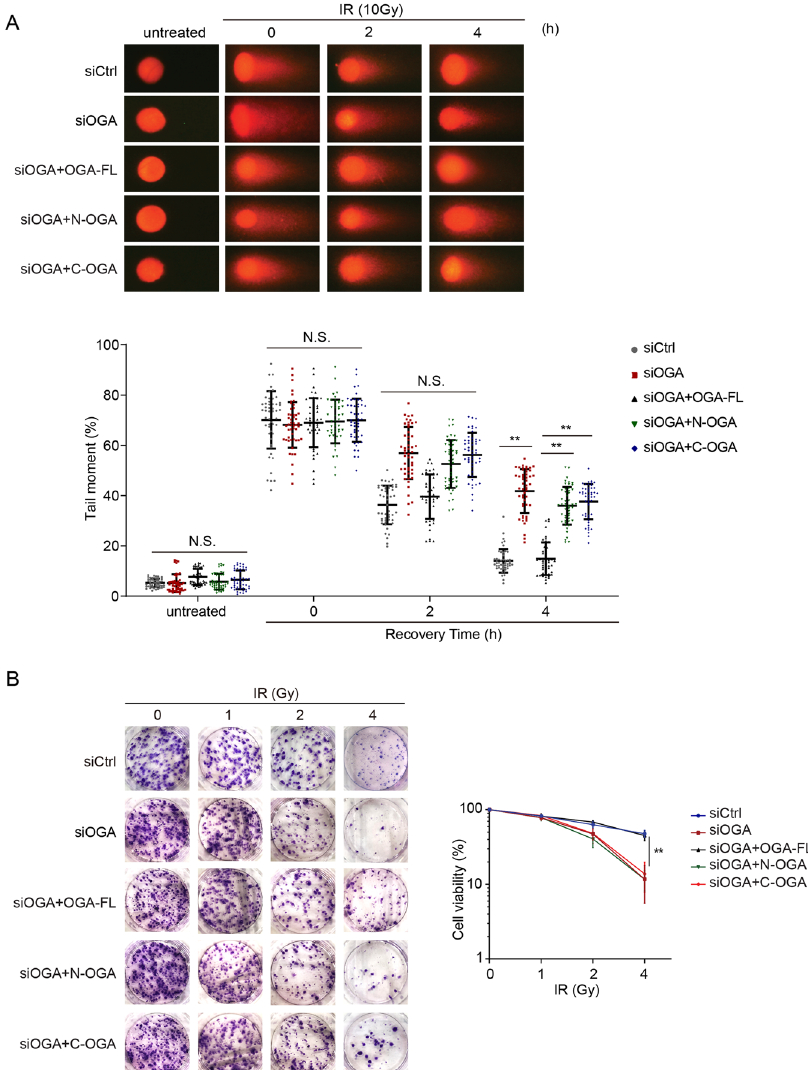
Fig. 2 OGA participates in DNA damage repair. A Loss of OGA impairs DNA damage repair. Cells were treated with siOGA and were reconstituted with full-length OGA, N-OGA, or C-OGA. The cells were then treated with 10 Gy of IR. DSB repair was examined by neutral comet assays (* P < 0.05). Tail moments were summarized from three independent experiments with 50 cells for a single time point per sample. The data are presented as mean ± SEM. B The cells lacking OGA are sensitive to IR treatment. Colony formation assays were performed in U2OS cells expressing full-length OGA, N-OGA, or C-OGA. The cells were treated with indicated doses of IR. Representative images of colonies in plates stained with Giemsa. The results were summarized from three independent experiments. The data are presented as mean ±